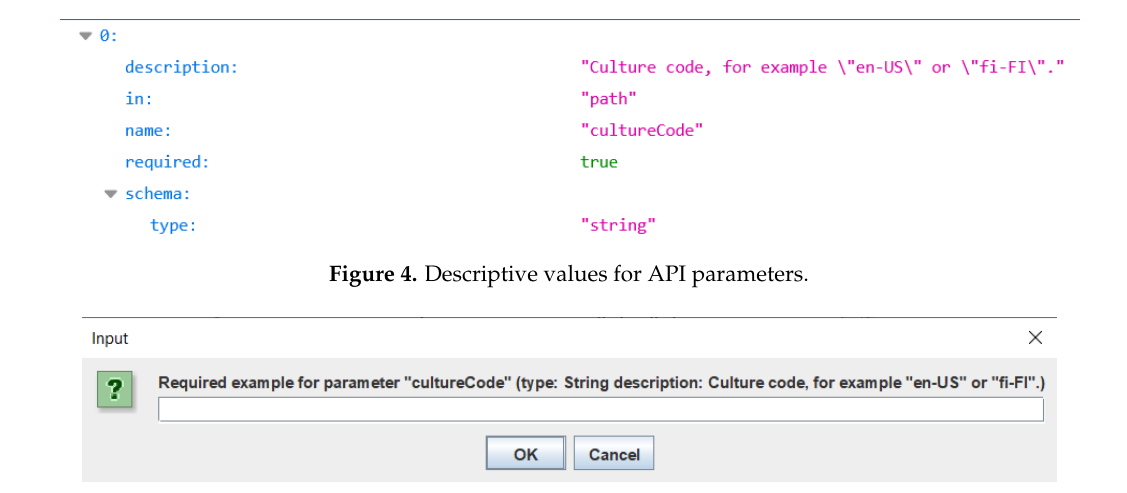
Figure 5. User input dialog example.